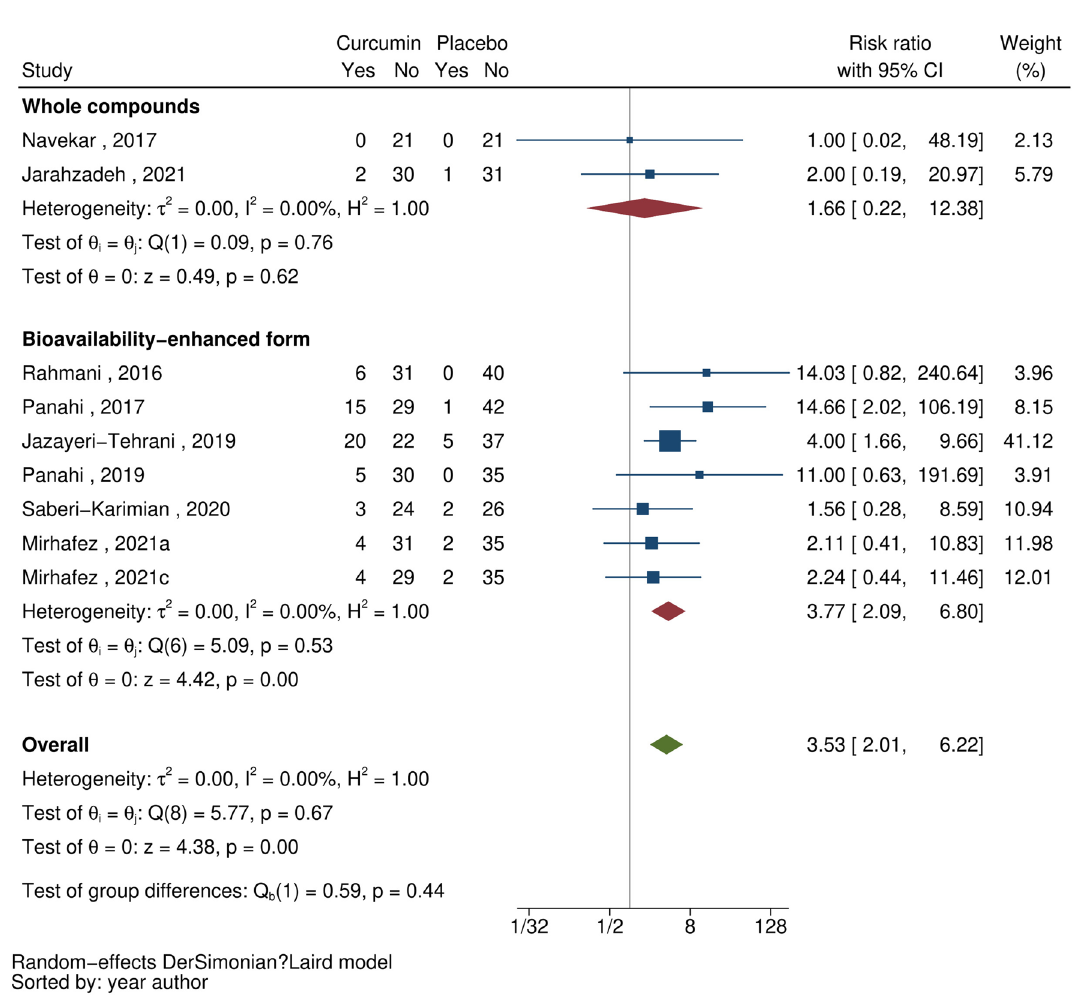
Figure 4. Forest plots demonstrating the effect of curcumin on the resolution of hepatic steatosis by